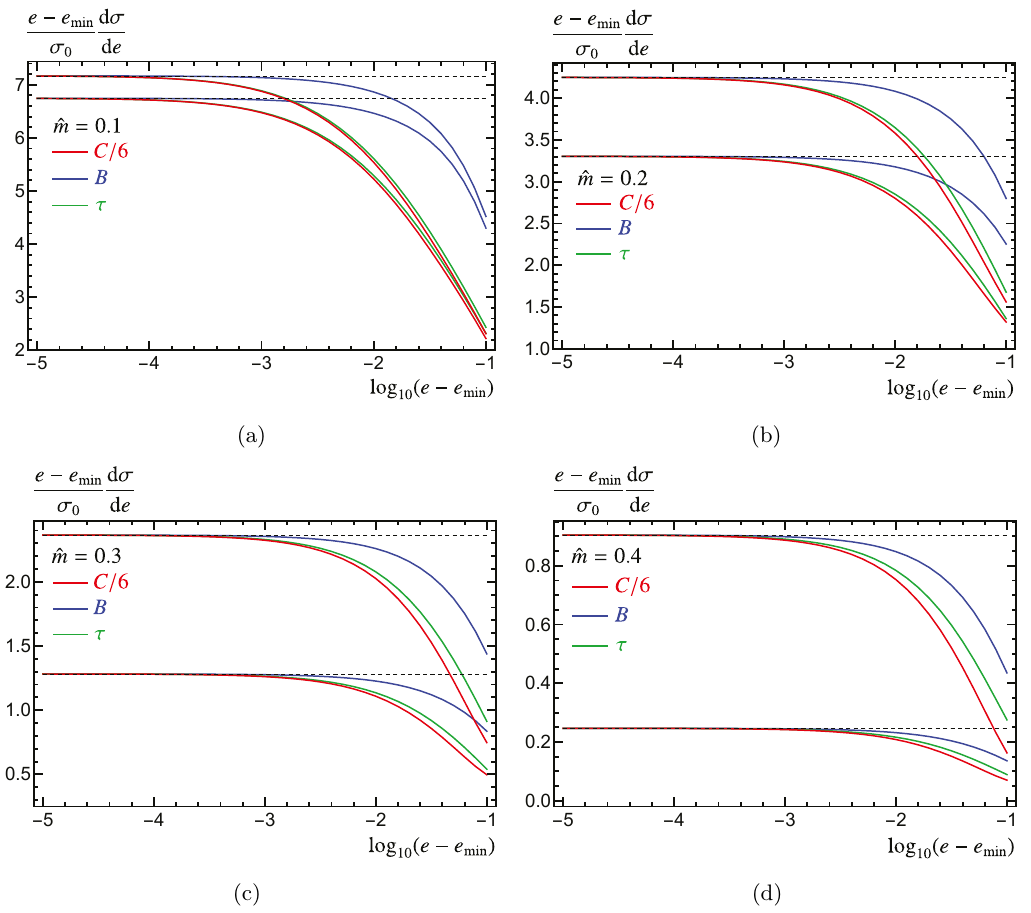
Figure 17 . Numerical determination of the plus-function coe(cid:14)cient. Panels (a), (b), (c) and (d) correspond to ^ m = 0 : 1 ; 0 : 2 ; 0 : 3 and 0 : 4, respectively. In each panel curves converging to the upper (lower) horizontal dashed line show vector (axial-vector) current results. The dashed lines show the analytical result of B plus for both currents. Thrust is shown in green, jet broadening in blue, and reduced C-parameter ( e C = C= 6) in